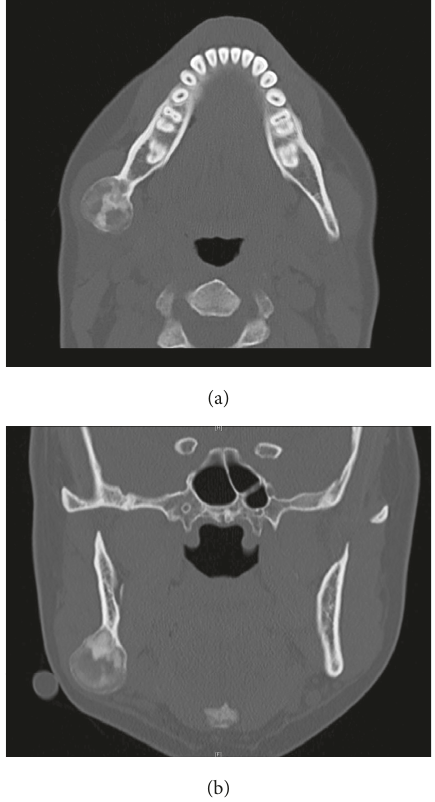
Figure 2: (a) CT axial cross section and (b) CT coronal cross section of an expansile mixed lesion of the right angle region of the